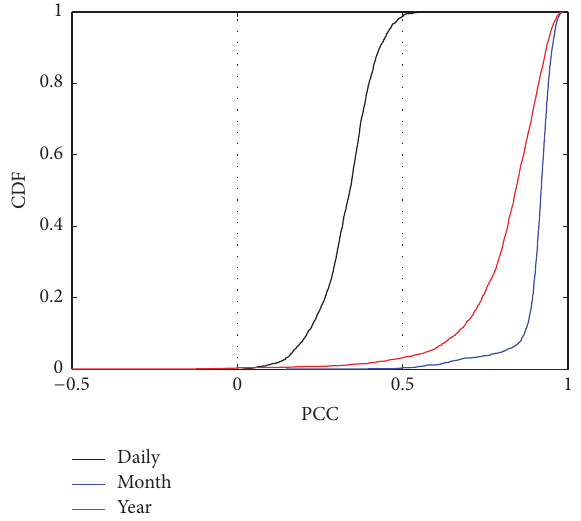
Figure 2: PCCs between gauge precipitation and TRMM precipita- tion in 2257